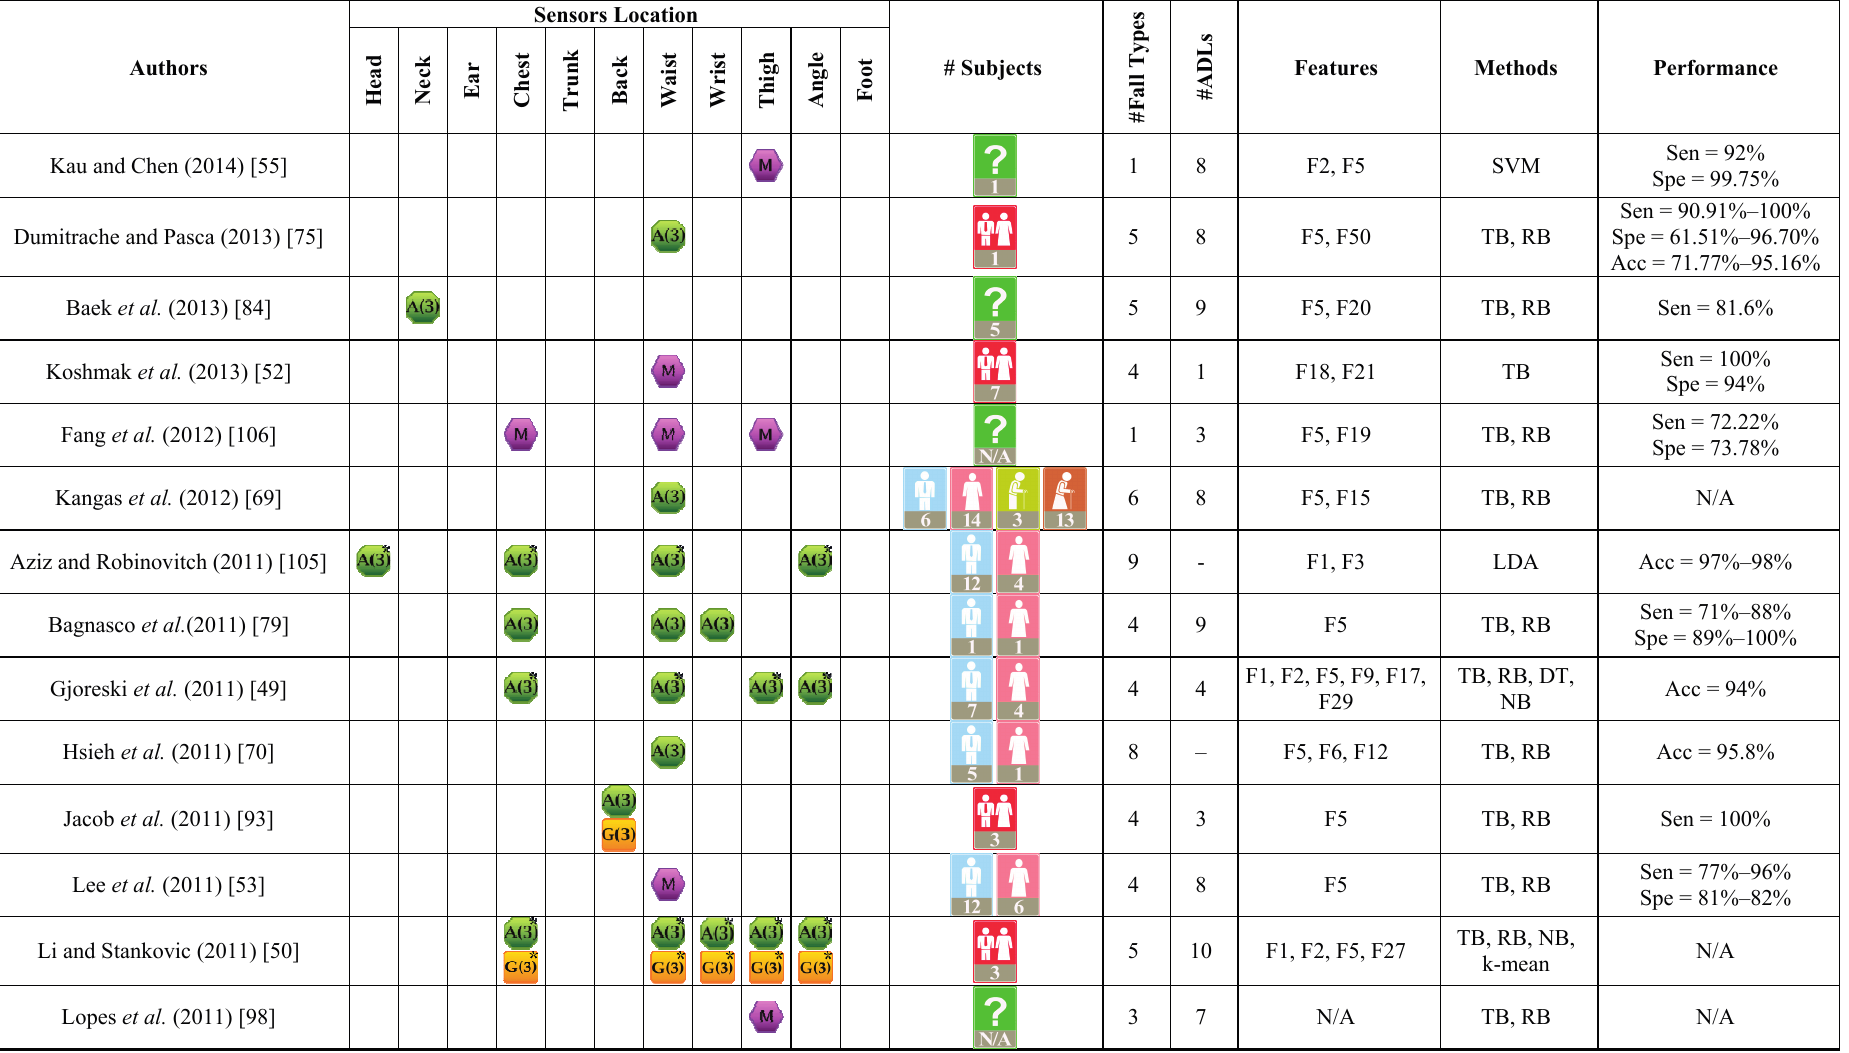
Table 5. Existing fall detection